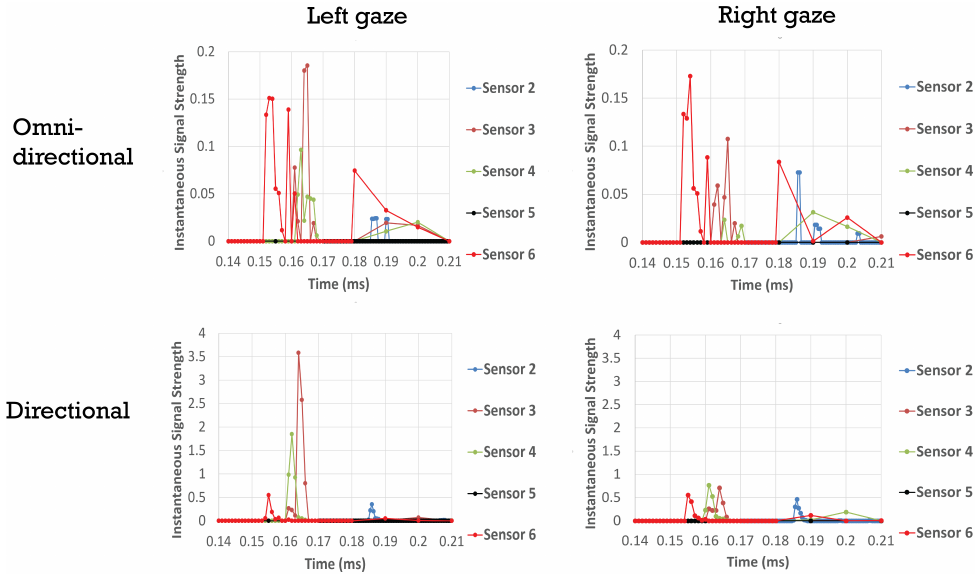
Figure 8. Modeled responses of ultrasound signal measured by the receiver with omni-directional and directional transducers. Left gaze reperesents a 30 degree rotation away from the nose, Rights gaze is 30 degrees towards the nose. Transducer 1 is not shown, as it operates only in transmit mode, see Figure 1.